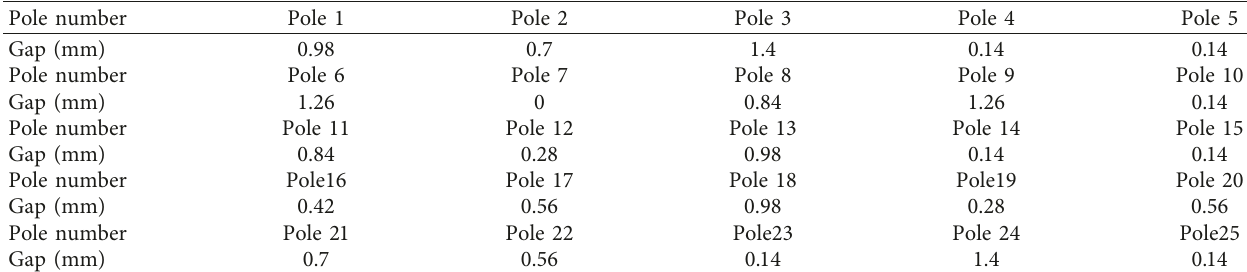
Table 1: Measurement results of the gaps at the top of the pole.